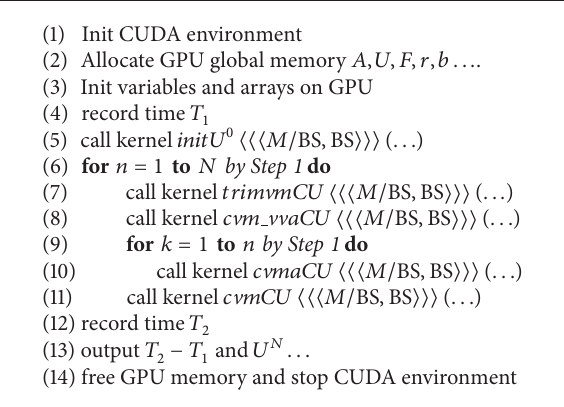
Algorithm 1: Parallel solution for Caputo fractional reaction- diffusion equation with